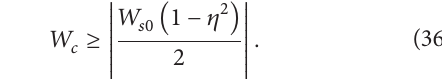
Figure 3: Regions of implementing